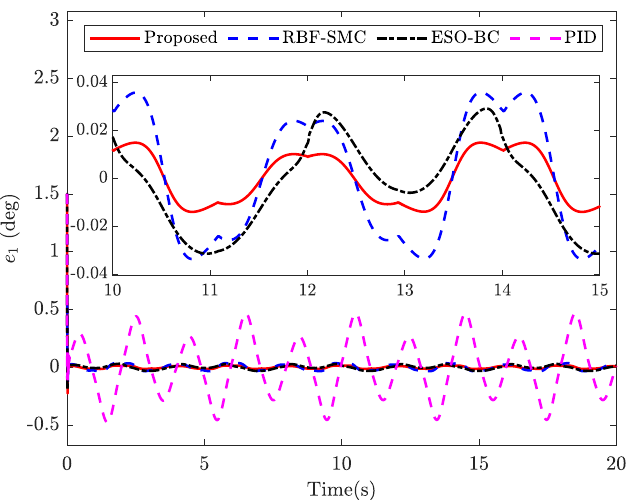
Figure 4. The tracking errors of the considered four control strategies with slow-motion refer- ence